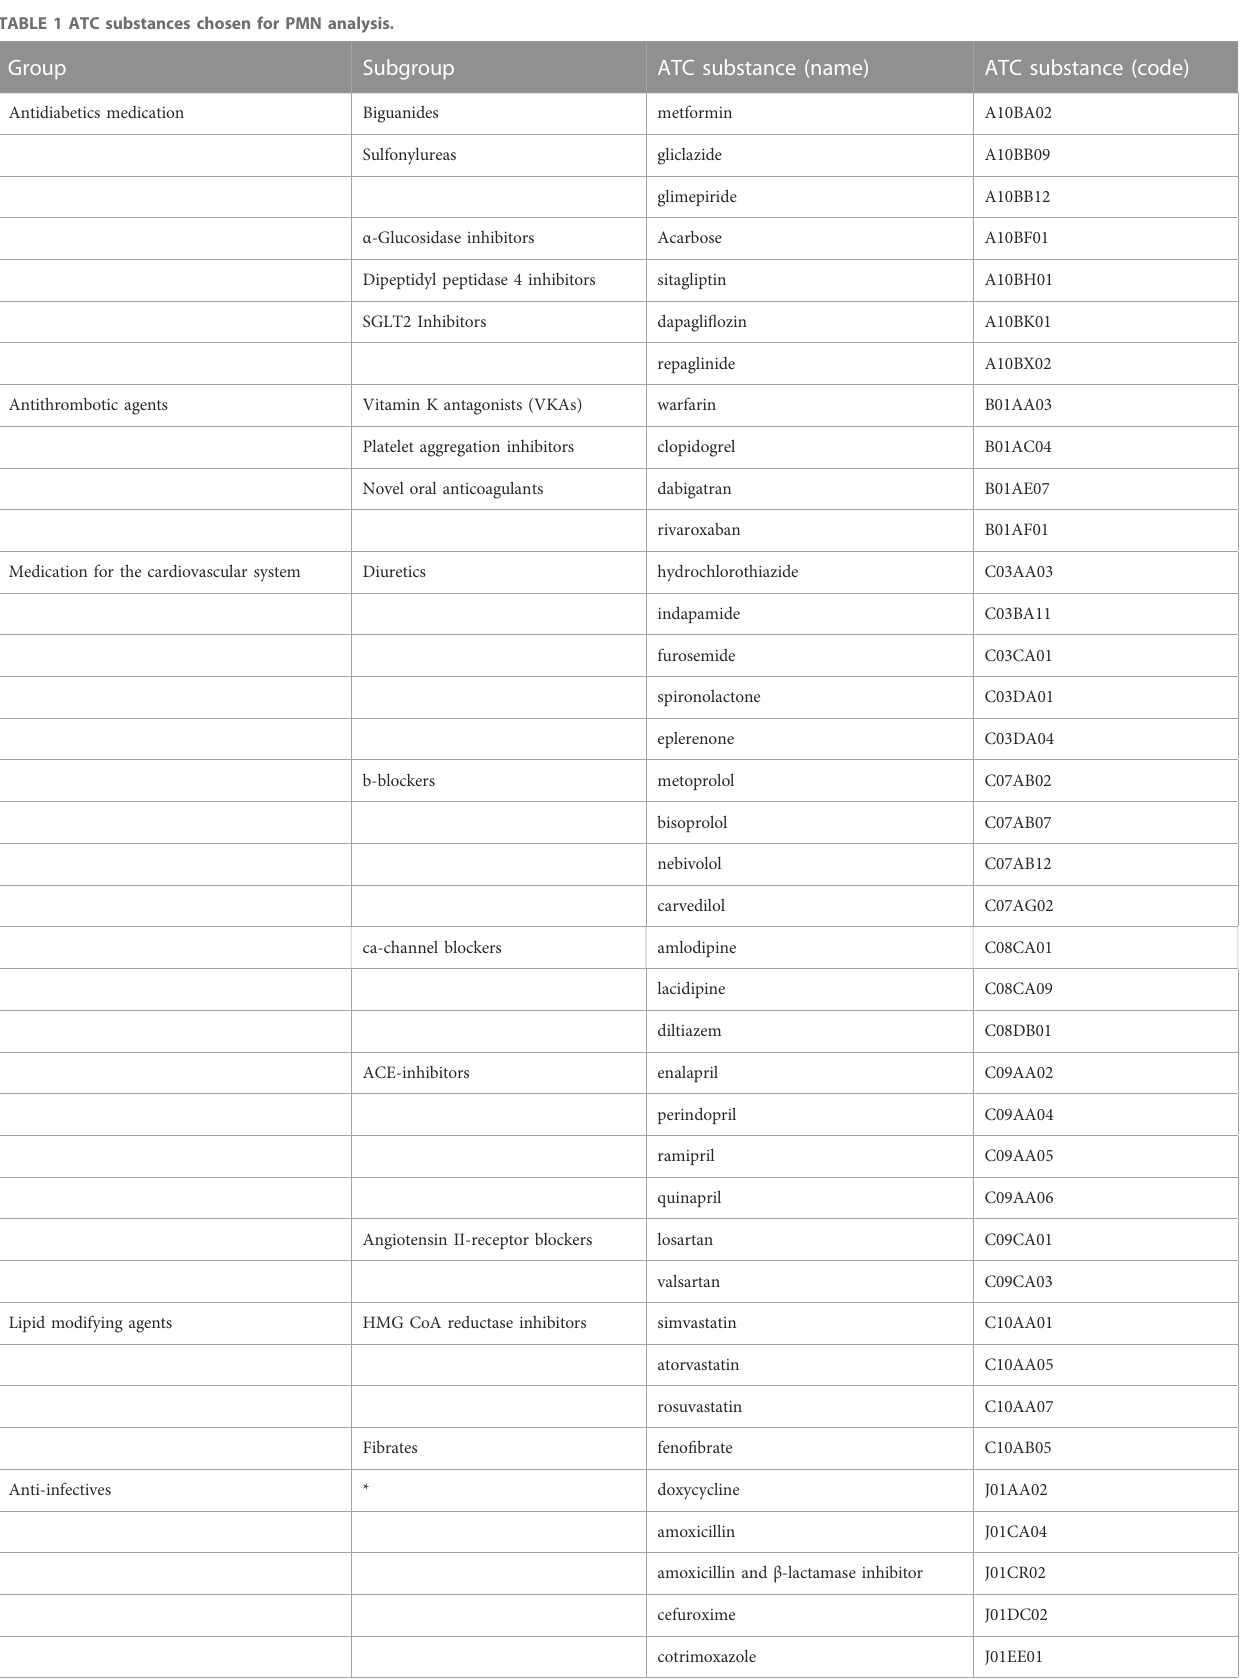
TABLE 1 ATC substances chosen for PMN